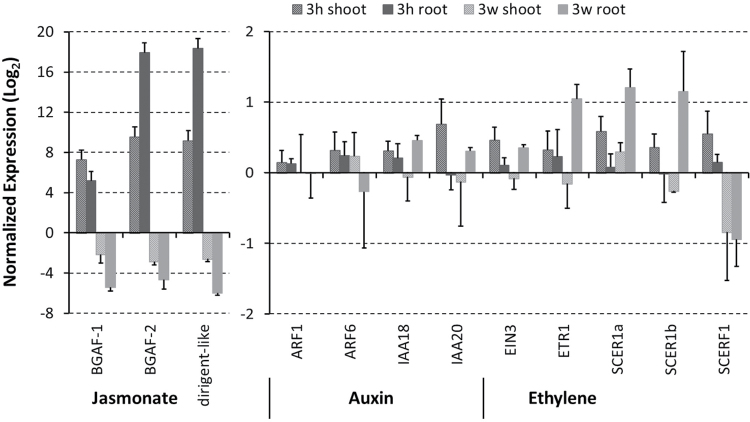
Normalized expression of M. sinensis transcripts related to hormones in response to H. frisingense (qRT-PCR, log2 scale). Note the different scale of jasmonate-regulated genes (BGAF-1, BGAF-2, and dirigent-like; left graph). Auxin-responsive genes were: auxin response factors ARF1 and ARF6, and the auxin-responsive IAA18 and IAA20 genes. Ethylene-related genes were ethylene insensitive 3 (EIN3), ethylene-resistant 1 (ETR1), the sugarcane ethylene receptor-like SCER1-like SCER1a and SCER1b, and the ethylene response factor SCERF1-like. A SCERF2-like gene (Cavalcante et al., 2007) was not identified in Miscanthus. 3h, 3h after inoculation; 3 w, 3 weeks after inoculation. Error bars: +SE of three (3h) or two (3 w) biological replicates. Qualitatively similar results were obtained from two further replicates.